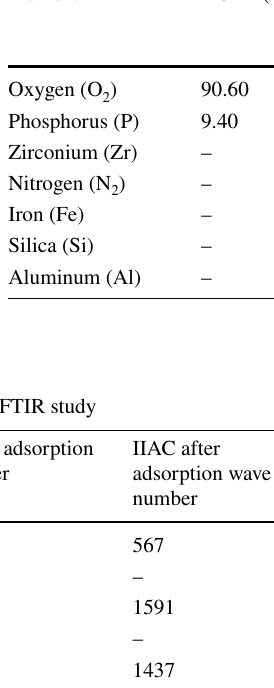
Table 3 Elemental analysis of EDS